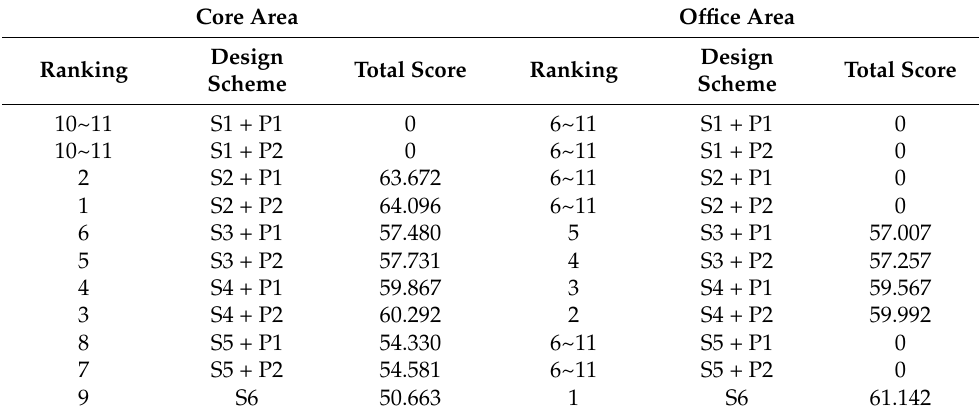
Table 11. Total scores and rankings of optional design schemes for two